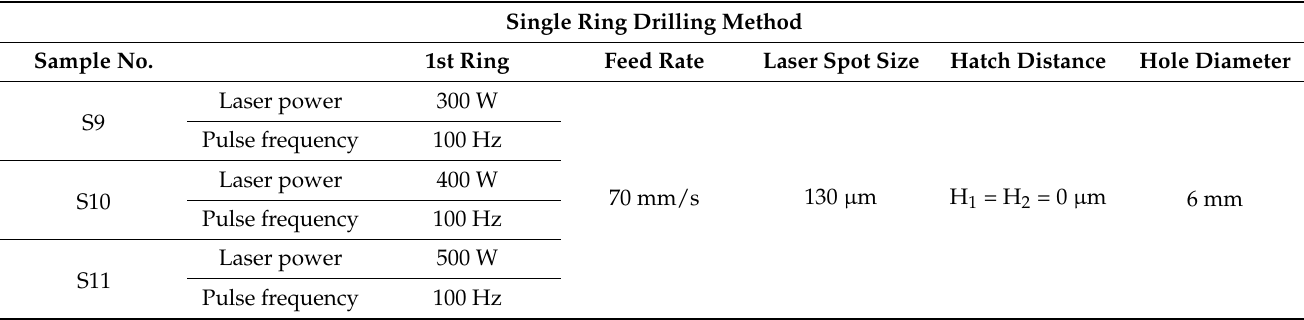
Table 3. Laser processing parameters for the single-ring drilling method. Single Ring Drilling